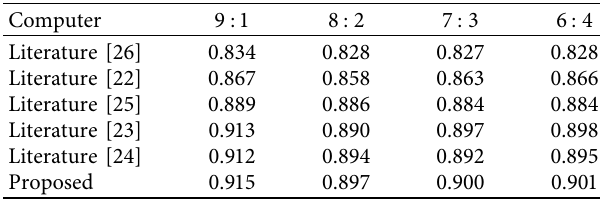
Table 4: Prediction performance comparison (computer).